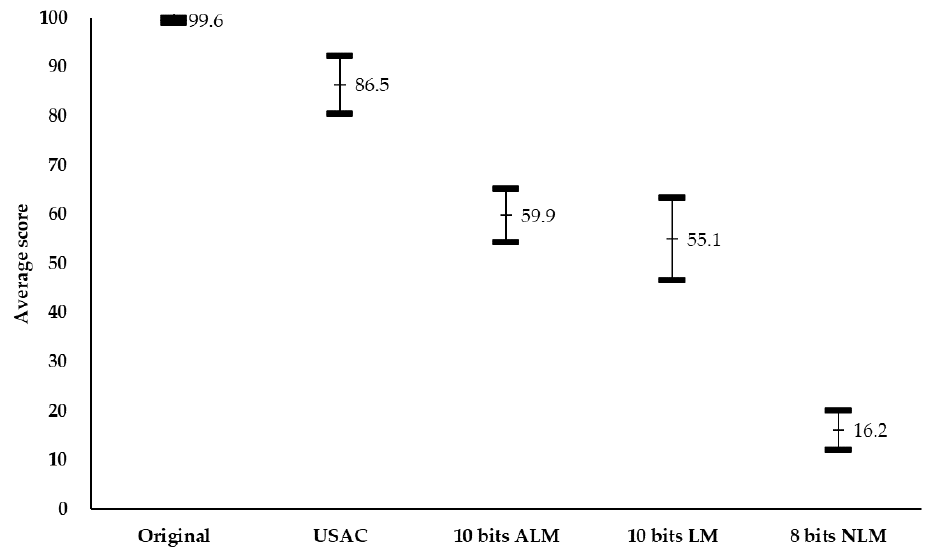
Figure 10. Scores of the MUSHRA listening test with a 95% confidence interval for different methods.